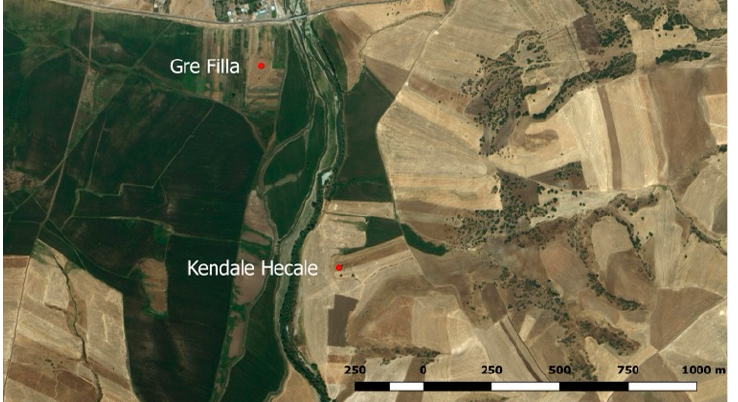
Figure 1. The aerial photography showing the locations of Gre Fılla and Kendale Hecala in the Ambar Çayı valley (Google Earth image).